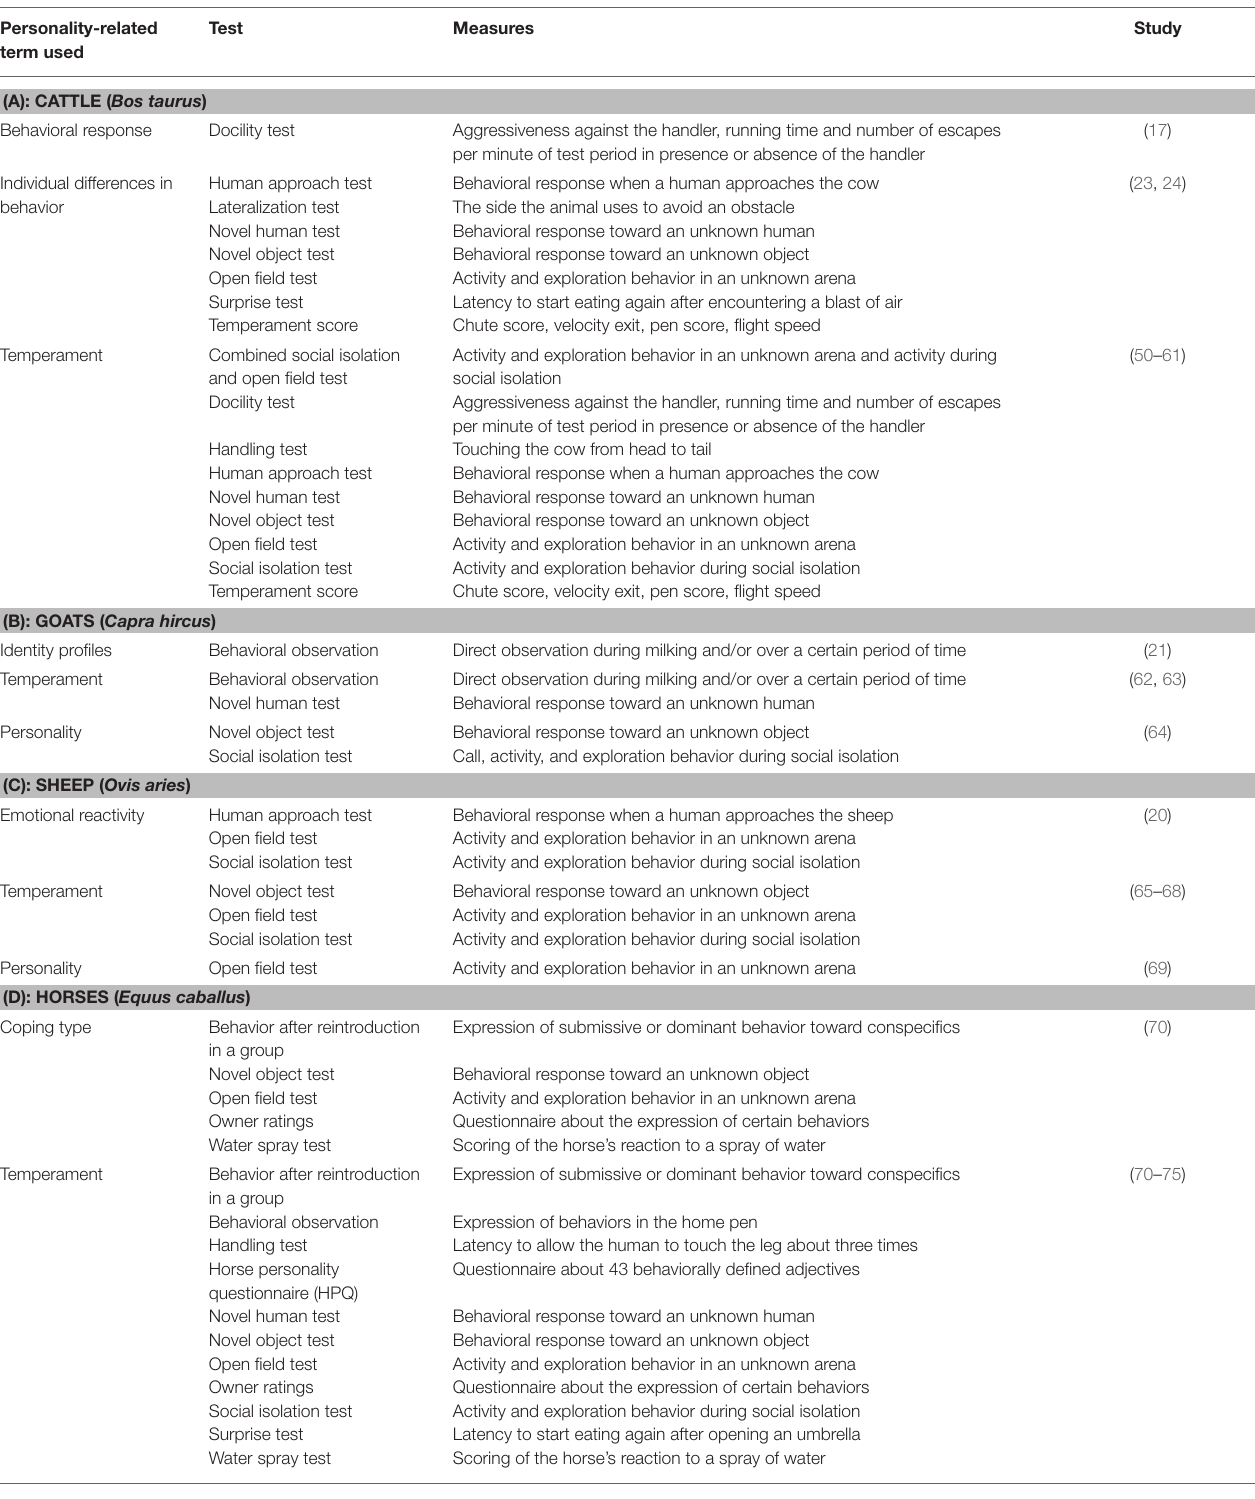
TABLE 2 | Selected studies assessing personality factors using different experimental designs in mammalian farm animals [2 (A) : cattle; 2 (B) : goats; 2 (C) : sheep; 2 (D) : horses; 2 (E) : pigs]. Personality-related term